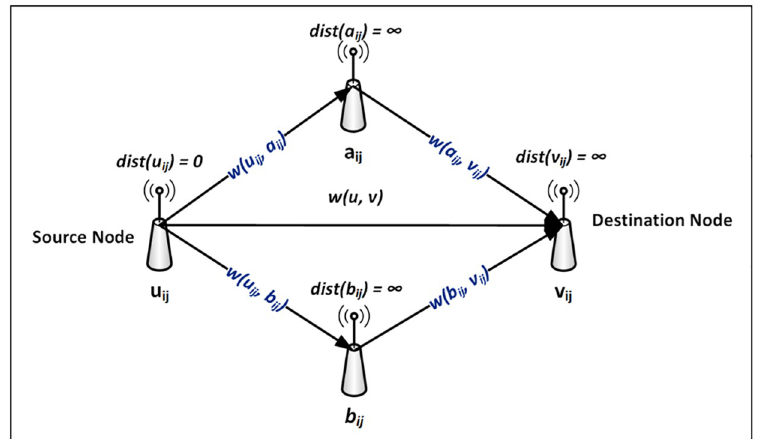
Fig 8. PSPCM shortest path